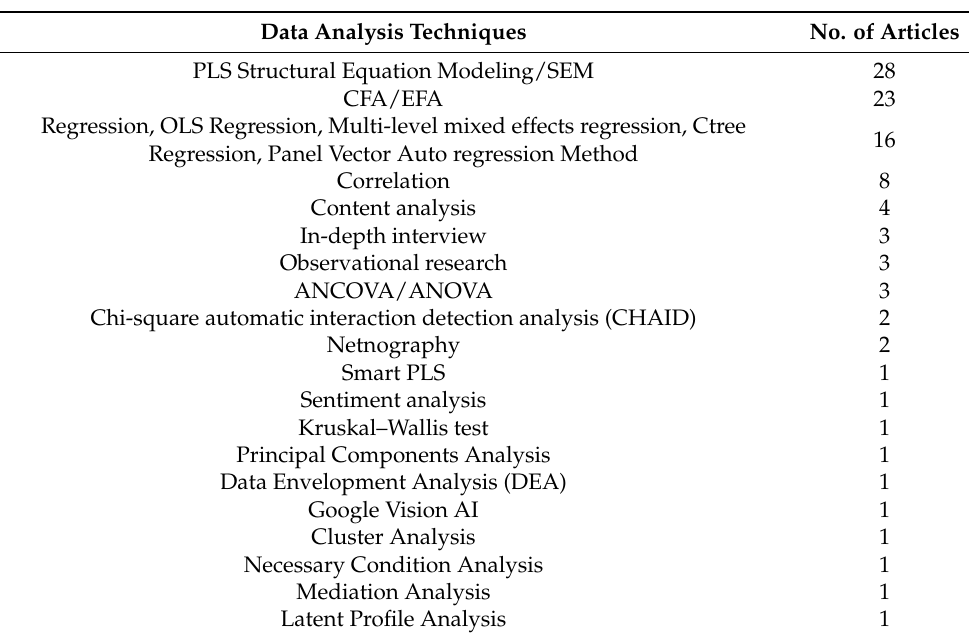
Table 4. Data analysis techniques adopted in the reviewed